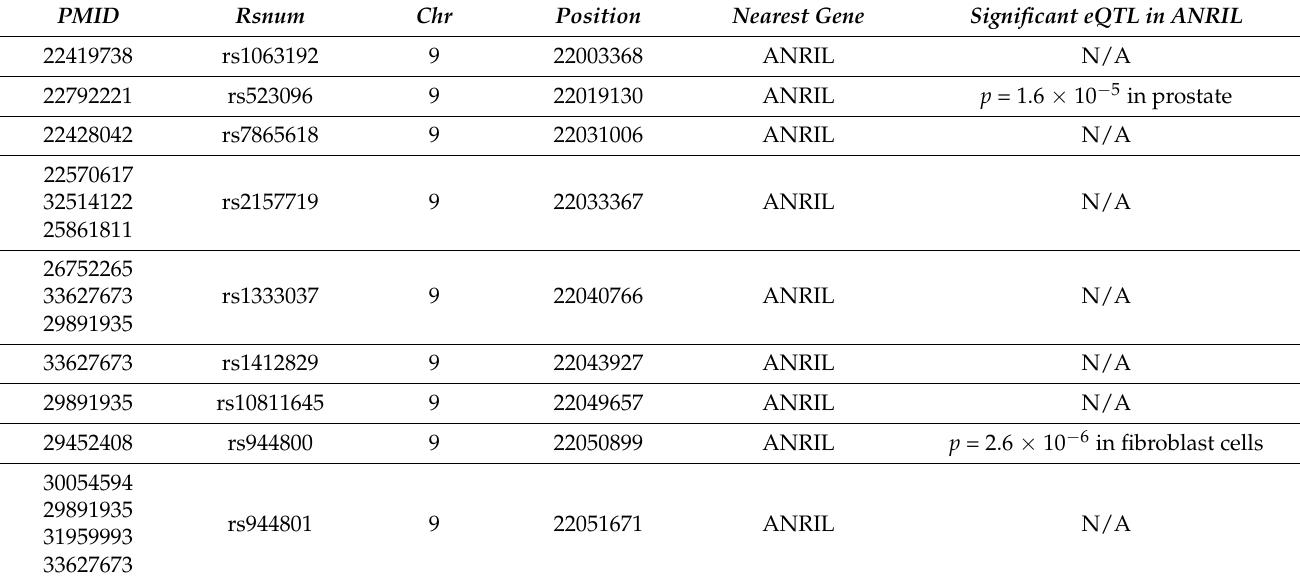
Table 1. GWAS risk variants of glaucoma in the genomic region of